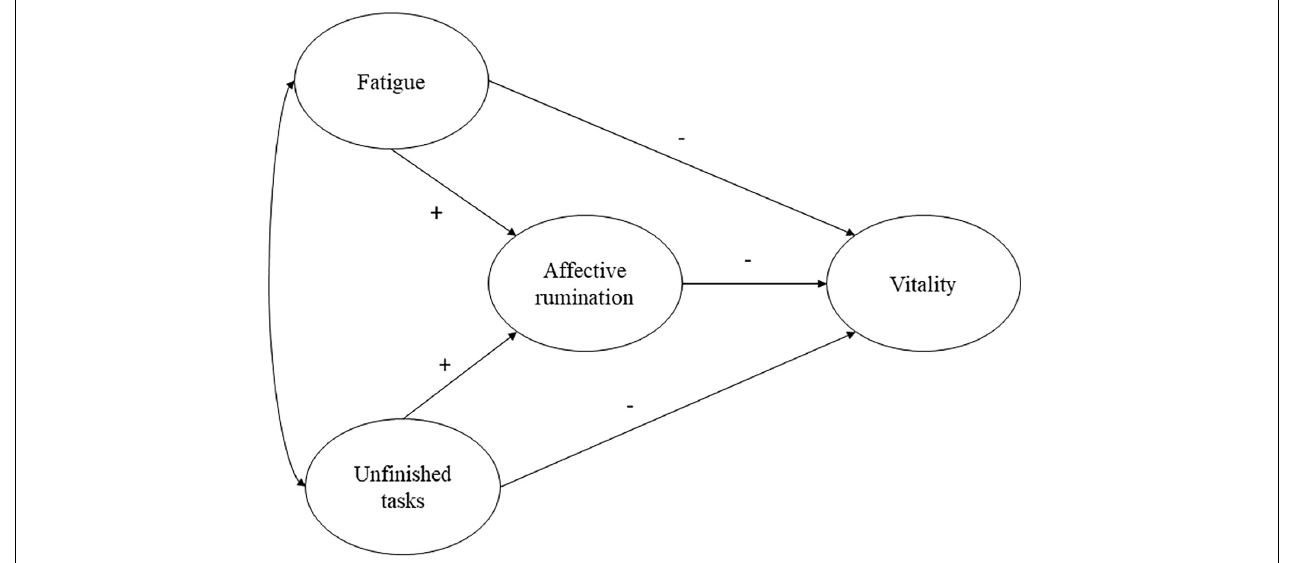
FIGURE 1 | Hypothesized model at the between- and within-person levels.